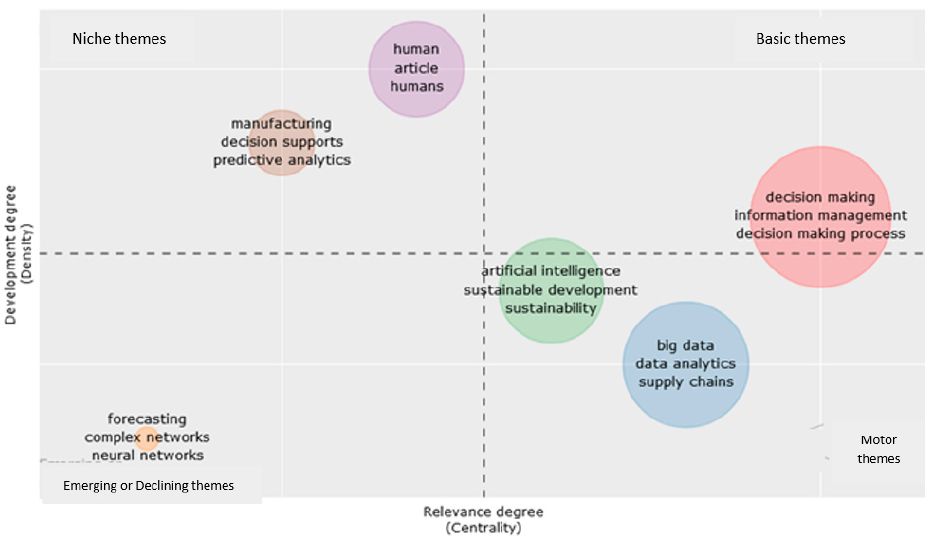
Figure 11. Thematic map based on keywords plus terms.